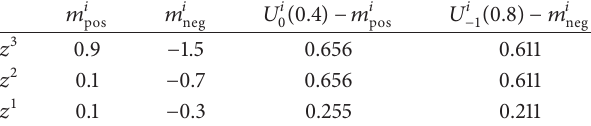
Table 2: Constants for type4 quotient digit selection